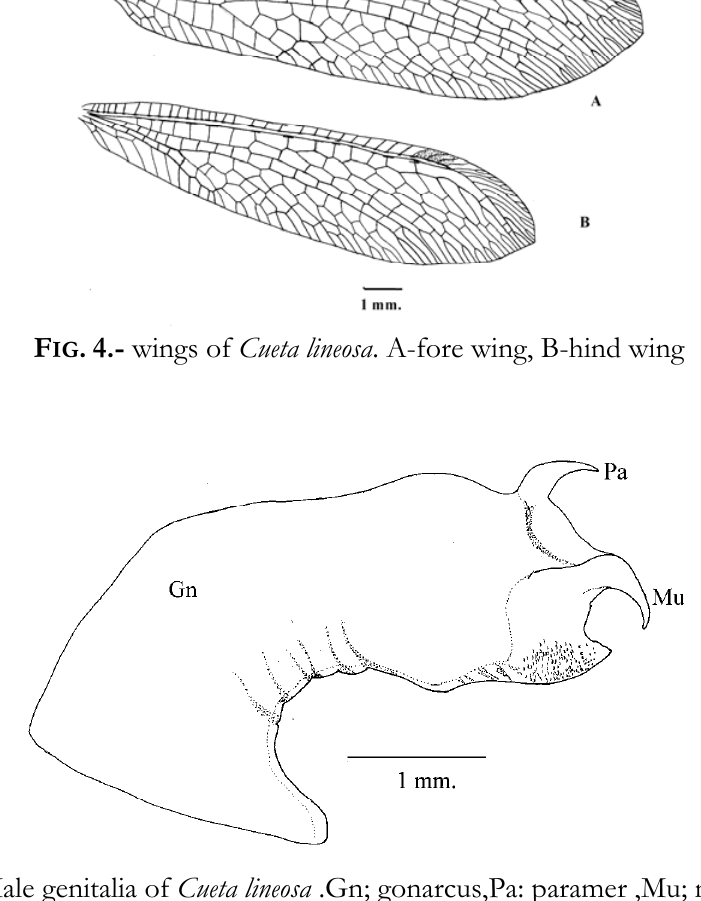
FIG . 5.- Male genitalia of Cueta lineosa .Gn; gonarcus,Pa: paramer ,Mu;